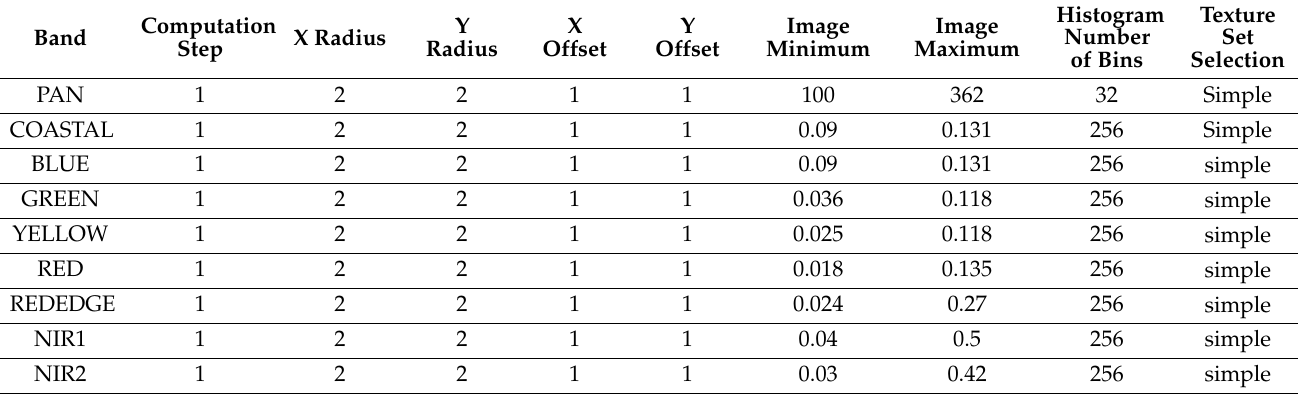
Figure A2. Leader board from AutoML run with 2-classes and VSURF ‘interpretation step’ ranked by AUC of 5-fold cross validation. Table A1. Haralick texture feature